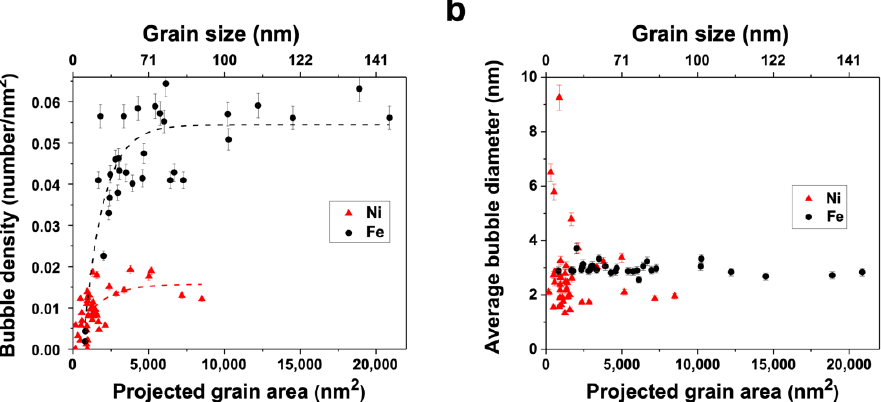
Figure 3. ( a ) Areal bubble density (number/nm 2 ) in the grain interiors correlated with grain size (nm 2 ) for 10 keV helium-implanted NC Ni (red triangles) and NC Fe (black circles); dotted line fitting demonstrates the trend in density change. ( b ) average bubble diameters correlated with grain area for the NC Ni and NC Fe grains, represented in Figure 3a. Fe data was adapted with permission from [27,28]. 2017, Elsevier, 2017, Taylor & Francis.